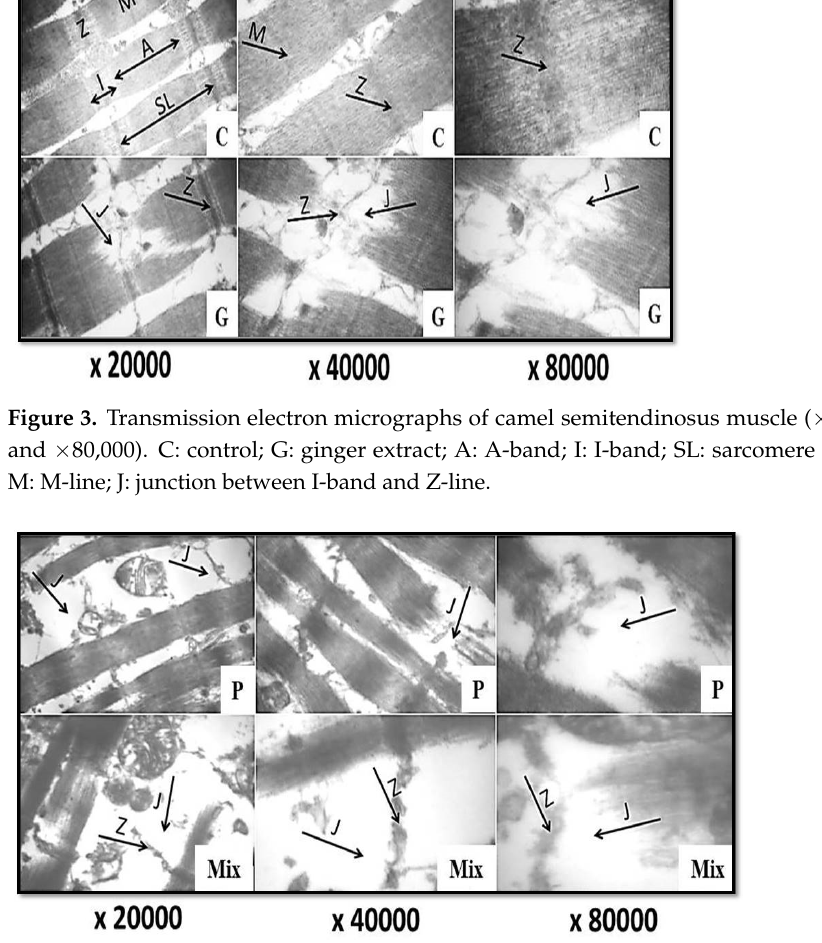
Figure 4. Transmission electron micrographs of camel semitendinosus muscle (×20,000, ×40,000, and ×80,000). P: papain-enzyme powder; Mix: a mixture of ginger and papain; Z: Z-line; J: junction be- tween I-band and Z-line.